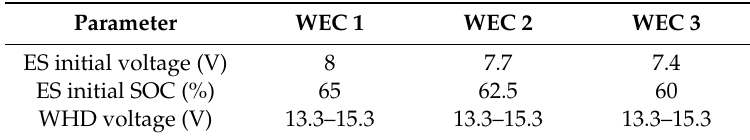
Table 2. Initial parameters of Tests 1 and 2.